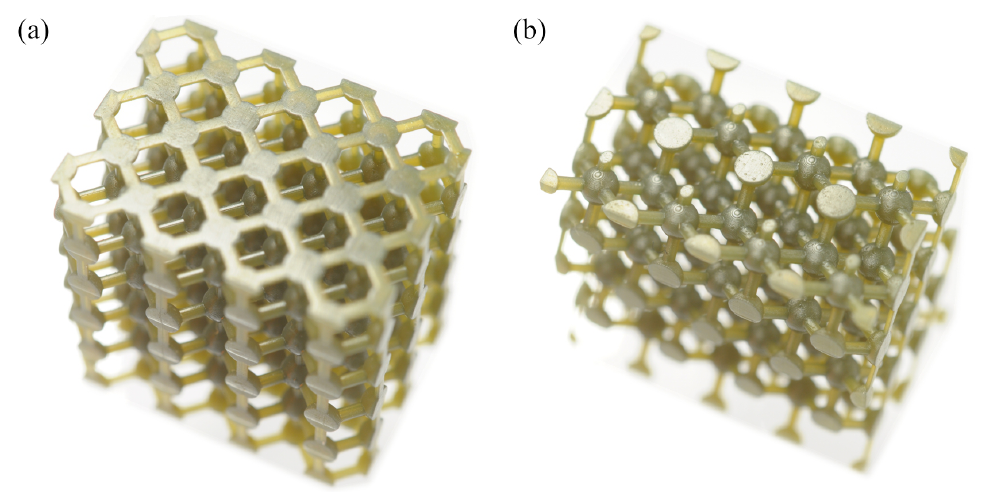
Figure 6. Fabricated samples of simple cubic corner balls with cylindrical beams corresponding to design Figure 1c ( a ) in center face diagonal Γ M and ( b ) body diagonal orientation Γ